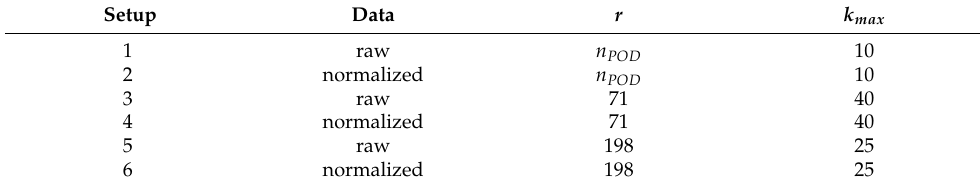
Table 8. Different settings for Gaussian mixture model.